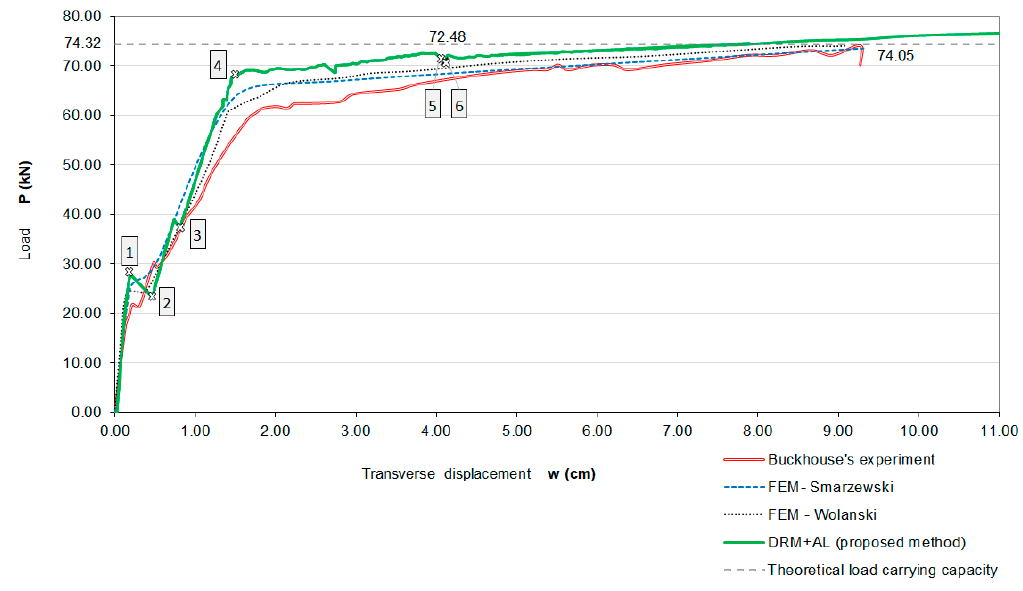
Figure 9. The numerical results using the proposed method for node 15 of the C1 beam compared with experimental and theoretical results from Buckhouse [27], Foley and Buckhouse [28], Smarzewski [35], and Wolanski [36]. and Wolanski